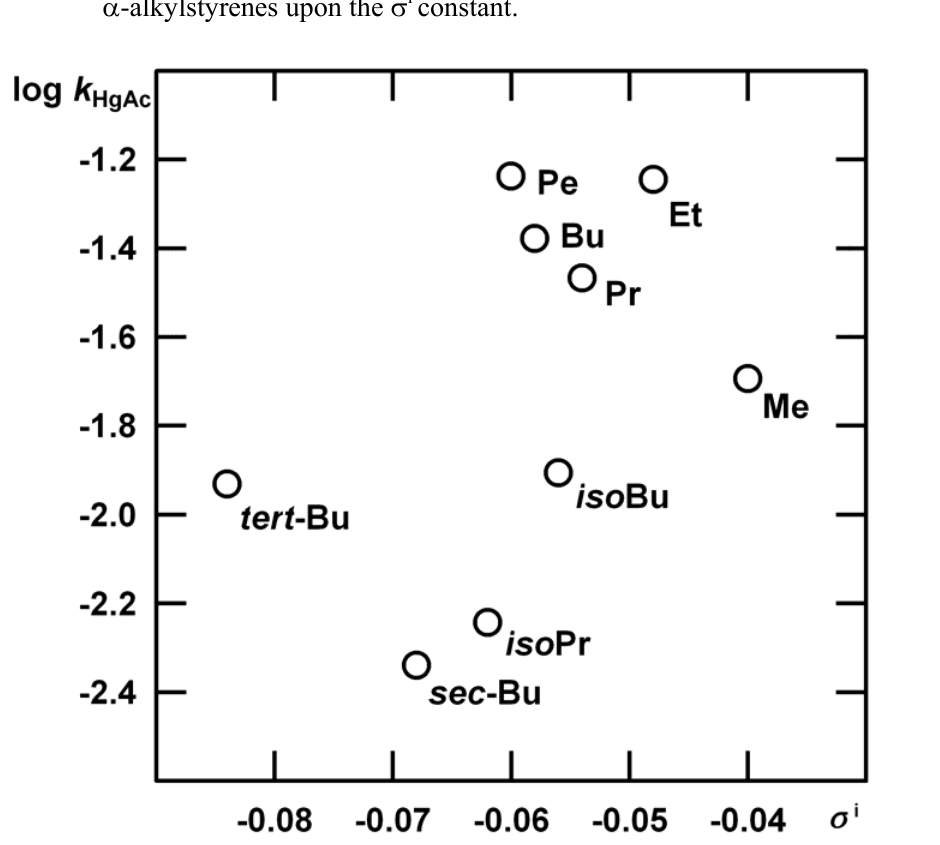
of acetoxymercuration of HgAc